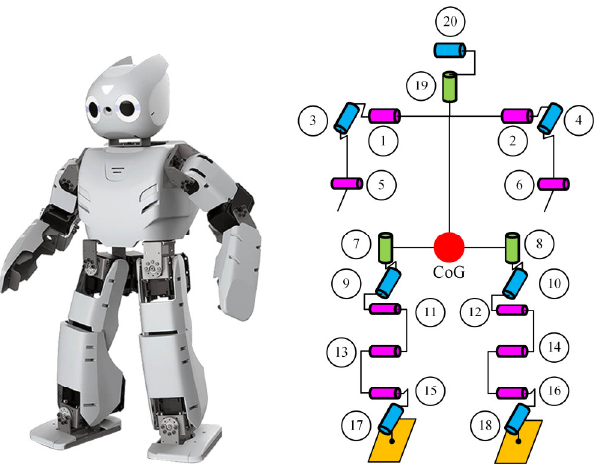
Figure 2. Robotis-OP2 humanoid robot and joint placement.